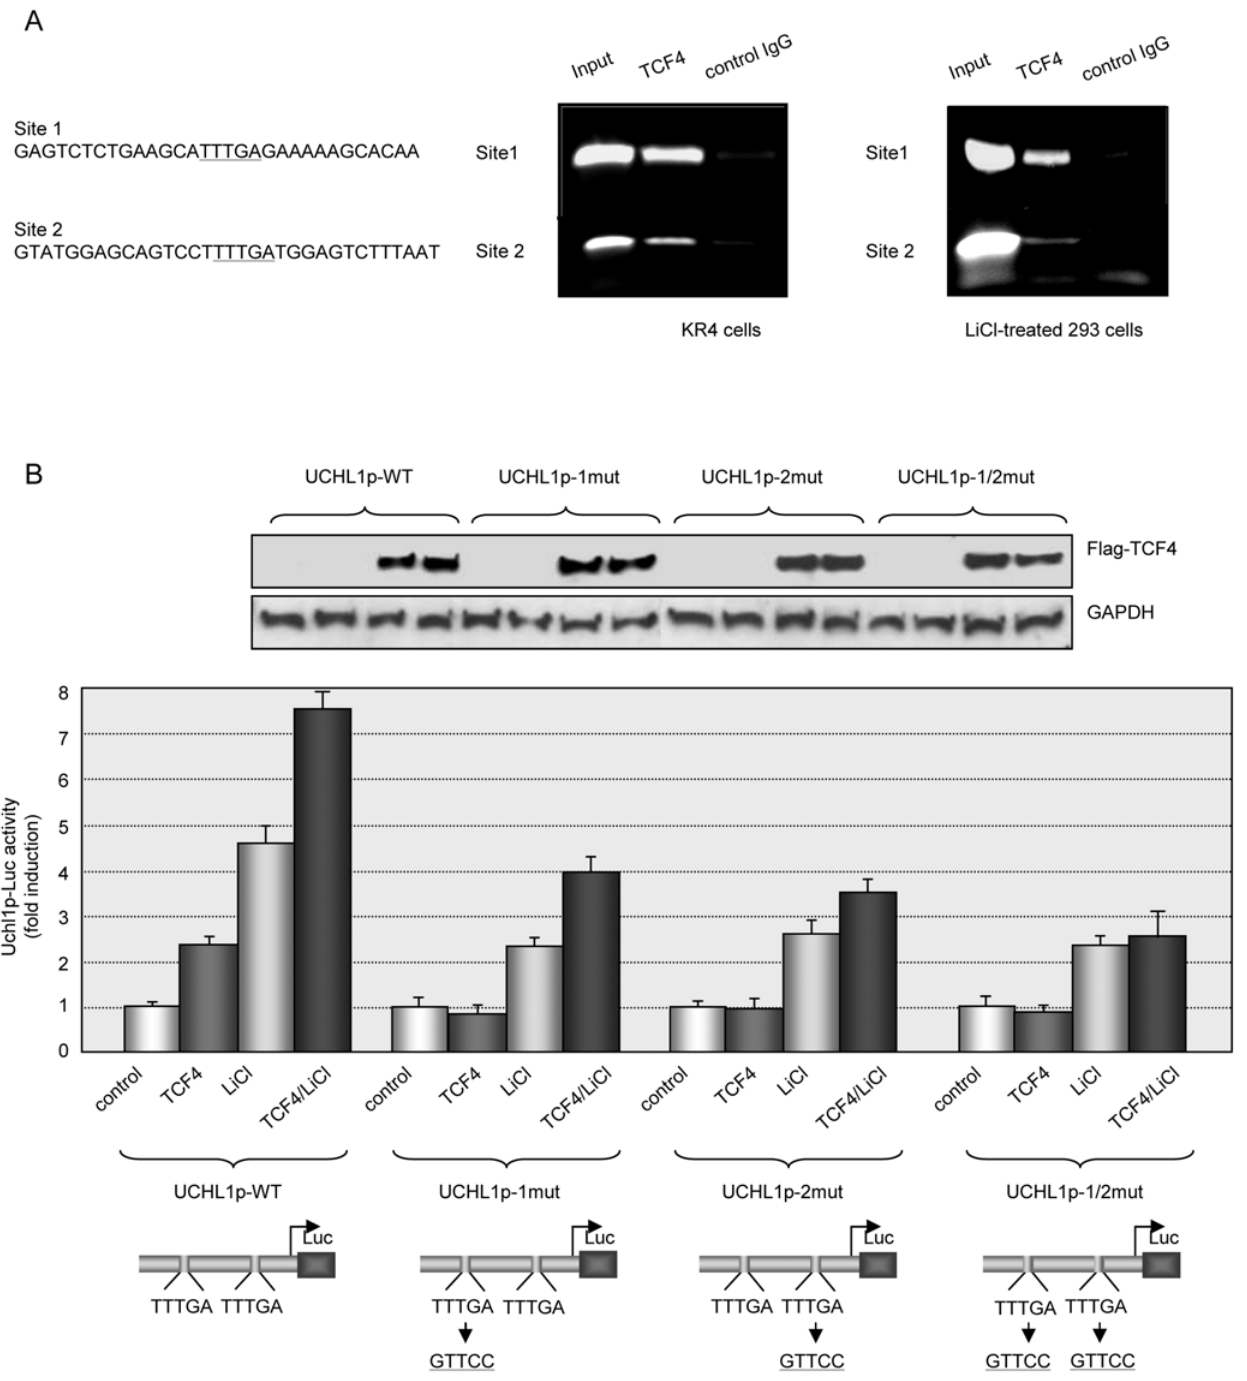
Figure 4. TCF/Lef factors up-regulate UCH L1 expression through direct binding to its promoter. A. TCF4 binds to endogenous uch l1 promoter. ChIP/PCR analysis was performed to determine binding of TCF4 factor to two putative binding sites on uch l1 promoter (left) with the use of specific TCF4 antibody in KR4 or 293 cells treated with 25 mM LiCl. Normal IgGs were used as a negative controls in IPs. PCR reactions were performed with primers targeting TCF4 binding sites on the uch l1 promoter (see Materials and Methods), and amplified DNA products were resolved in 2% agarose gel. B. Mutations in TCF/Lef putative sites inhibit b -catenin/TCF4-dependent activation of the uch l1 promoter. Site- directed mutagenesis of TCF/Lef binding sites was performed as described in Materials and Methods. 3T3 cells were transfected with Uchl1p-Luc wild type and mutant reporter plasmids in the presence or absence of TCF4 expression vector. Luciferase assays were performed 48 h post-transfection and are normalized to b -gal activity. Where indicated 25 mM LiCl was added to the cells 6 h before harvesting. Expression of TCF4 was confirmed by Western blotting.